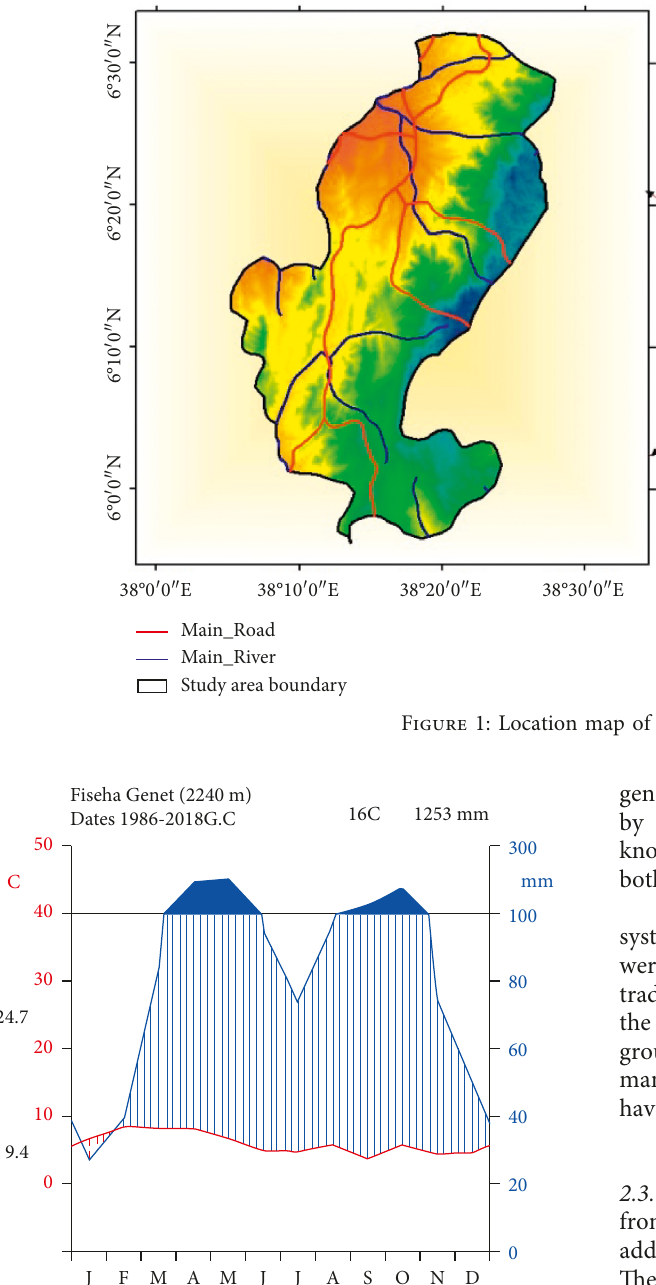
Figure 2: Map of climatic diagram of the district at the main station of Fiseha Genet. Source (National Meteorological Agency